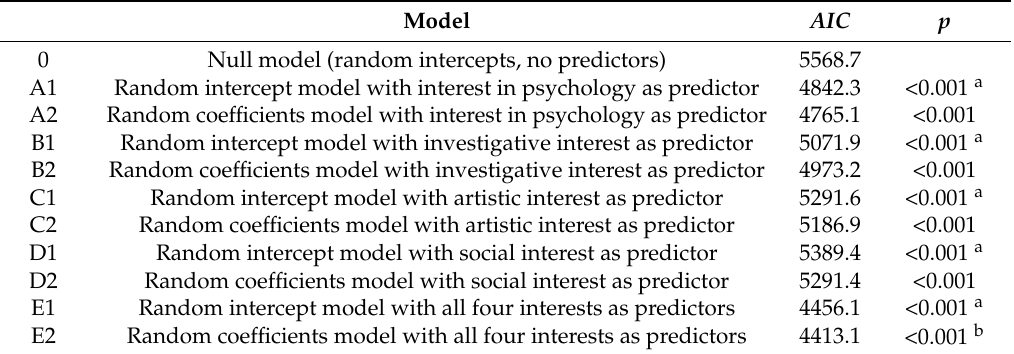
Figure 3. Regression lines for Openness as a function of interests, person-specific (thin) and average (thick). Table 2. Fit information for hypothesized models predicting openness and relevant comparisons.